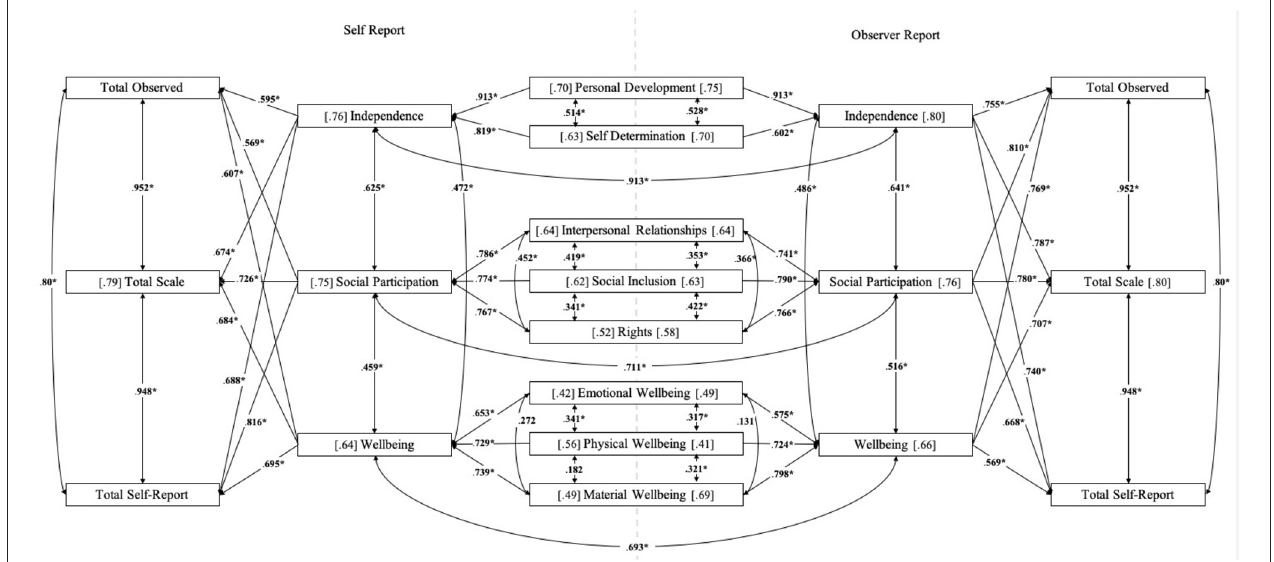
FIGURE 1 | Outcomes relating to the [Cronbach’s alpha] and between-within scale (correlations). The left side of the figure relates to the self-report POS outcomes, and the right, demarked by the dashed vertical line, relates to the observer report. Note, a Cronbach’s alpha are reported in chain brackets [ ], and ≥ 60 is considered acceptable. Correlations are reported along the line which relates to the variables in question and significance is represented by * p ≤ 0.05.